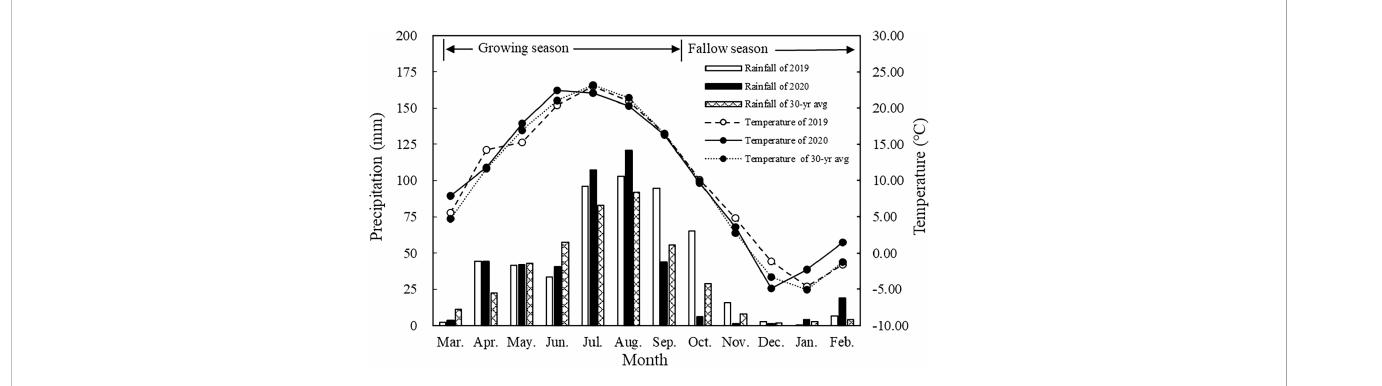
FIGURE 2 Monthly average precipitation and temperature in Huanxian experimental